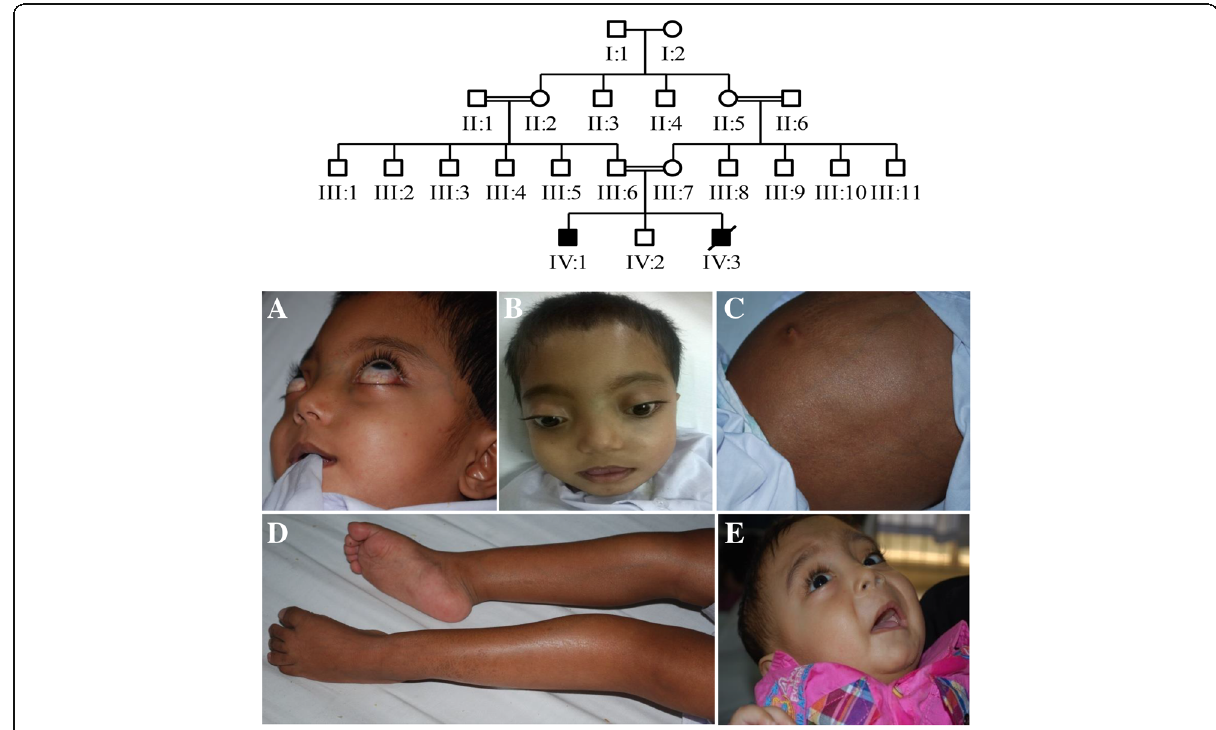
Fig. 1 The ARO family pedigree & clinical presentation of patients. Upper panel; Pedigree of consanguineous multi-generation Pakistani family demonstrating segregation of osteopetrosis as an autosomal recessive trait. Lower panel; ( a ) Patient IV-1, a 3-year-old boy with craniofacial symptoms showing exophthalmoses ( b ) macrocephaly, frontal bossing, flat nasal bridge and hypertelorism ( c ) protuberance of abdomen due to hepatosplenomegaly ( d ) limb deformities and muscle wasting. ( e ) Patient IV-3, a 1-year-old boy with less severe skeletal features including macrocephaly, flat nasal bridge with hypertelorism and mild